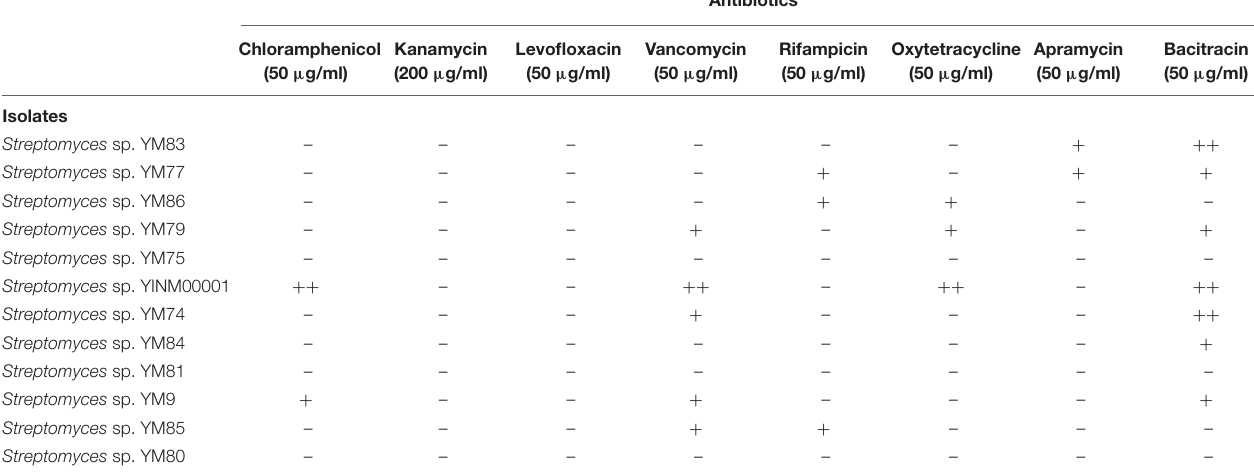
TABLE 2 | Antibiotic resistance assay of Streptomyces